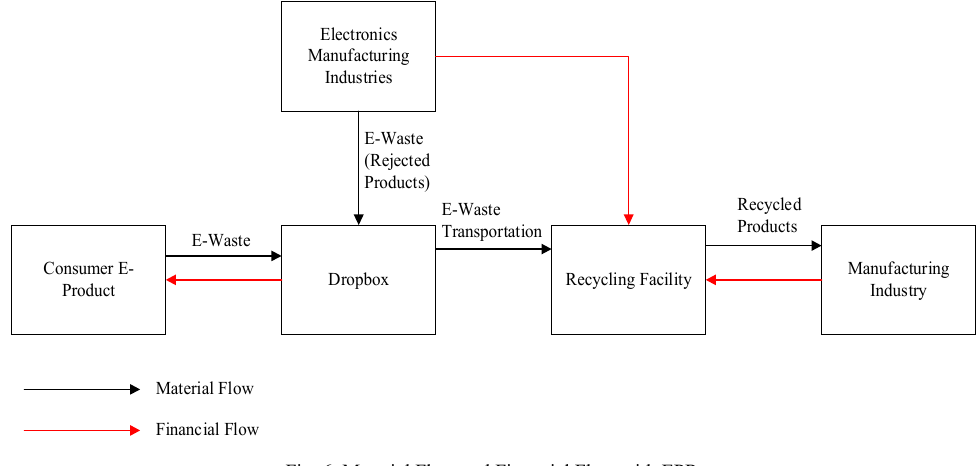
Fig. 6. Material Flow and Financial Flow with